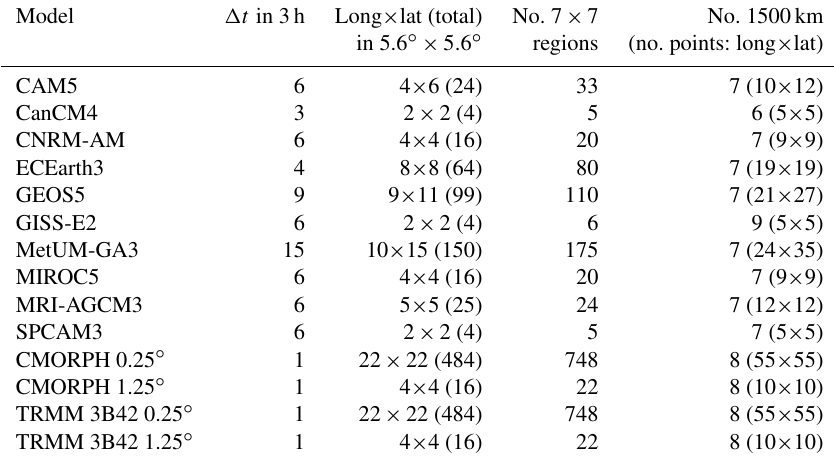
Table 2. For each model, as well as TRMM 3B42 and CMORPH: the number of time steps in 3h; the dimensions (in native gridpoints) of the 5.6 ◦ × 5 . 6 ◦ × averaging regions discussed in the text, with the total number of native gridpoints averaged together shown in parentheses; the number of 7 × 7 native gridpoint regions in the analysis domain; and the number of ≈ 1500km × 1500km regions in the analysis domain, with the dimensions (in native gridpoints) on each side of the region shown in parentheses. Note that while GISS-E2 and SPCAM3 have the same resolution, they have different numbers of 7 × 7 gridpoint and 1500km × 1500km regions because of the staggering of their native grids relative to the 10 ◦ S–10 ◦ N, 60–160 ◦ E analysis region.